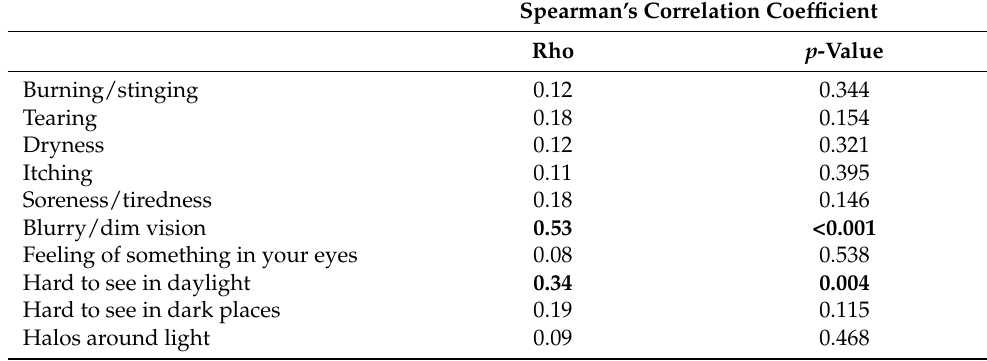
Table 3. Correlation of Glaucoma Symptom Scale (GSS) results with overall patient satisfaction. Spearman’s correlation coefficient and p -values are